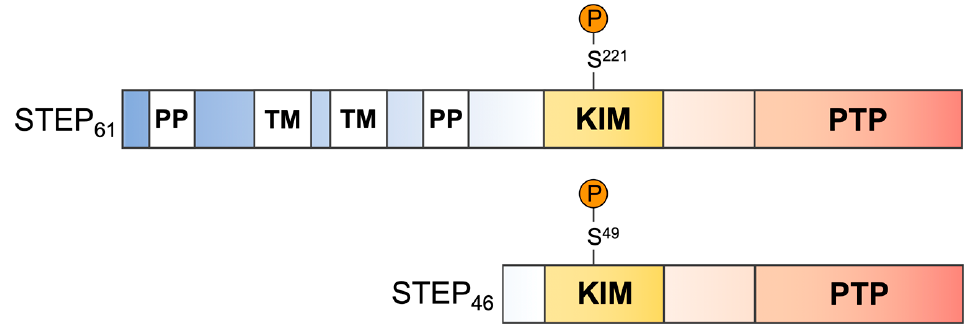
Figure 1. Major STEP splice variants STEP 61 and STEP 46 . PP, polyproline-rich motif; TM, transmembrane motif; KIM, kinase-interaction motif; and PTP, catalytic domain. Calcineurin dephosphorylation of S221/49 is required for STEP activation.